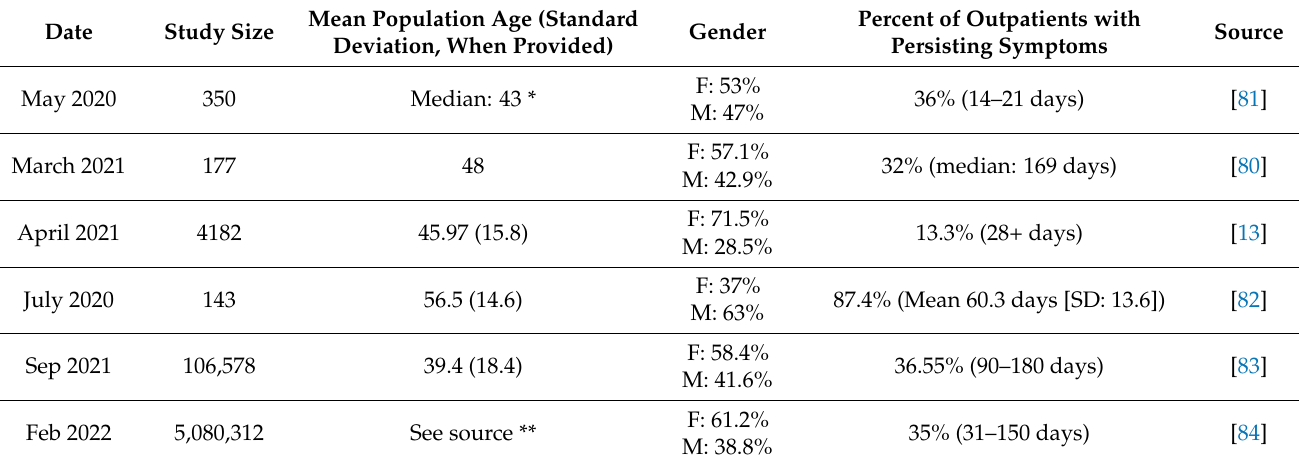
Table 4. Studies reporting long-COVID data and the percent of outpatients with persisting